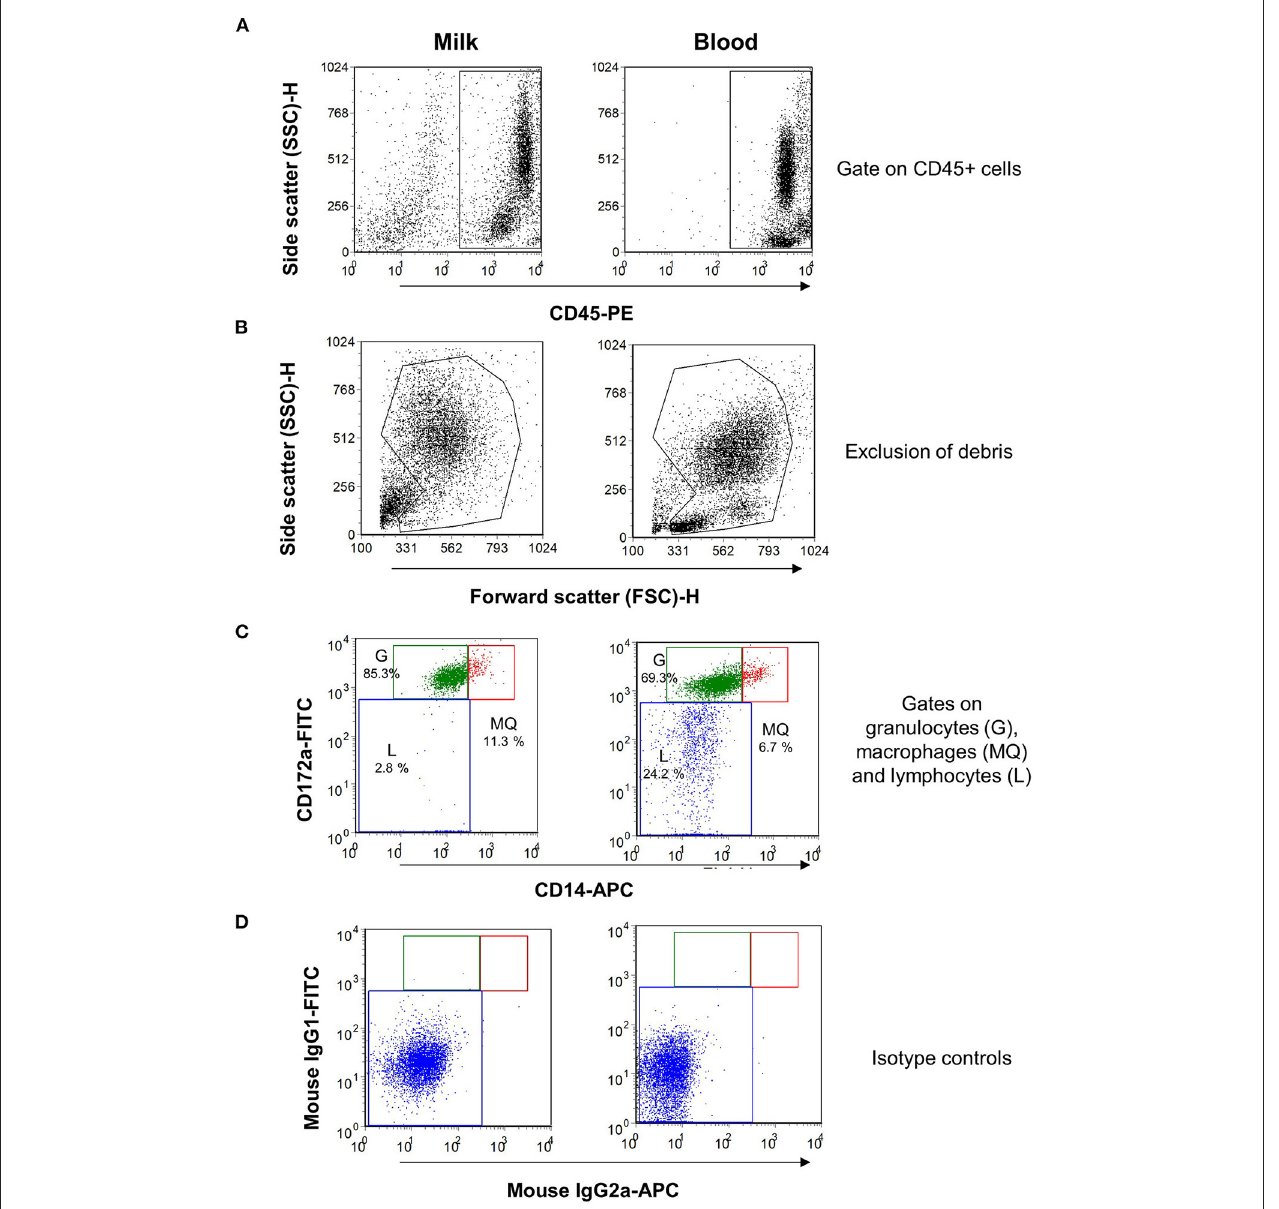
FIGURE 1 | Flow cytometric analysis of leukocytes in milk and blood from dromedary camel. Separated milk and blood leukocytes were labeled with monoclonal antibodies to CD45, CD172a, and CD14, and stained cells were analyzed by flow cytometry. (A) Using an SSC/CD45 gate, milk, and blood leukocytes were identified as CD45-positive cells. (B) Cell debris were excluded in an FSC-H/SSC-H dot plot. (C) Milk and blood granulocytes (G), macrophages (MQ), and lymphocytes (L) were identified based on their staining with monoclonal antibodies to CD172a, and CD14. (D) Cells stained with mouse IgG1 and IgM isotype controls.